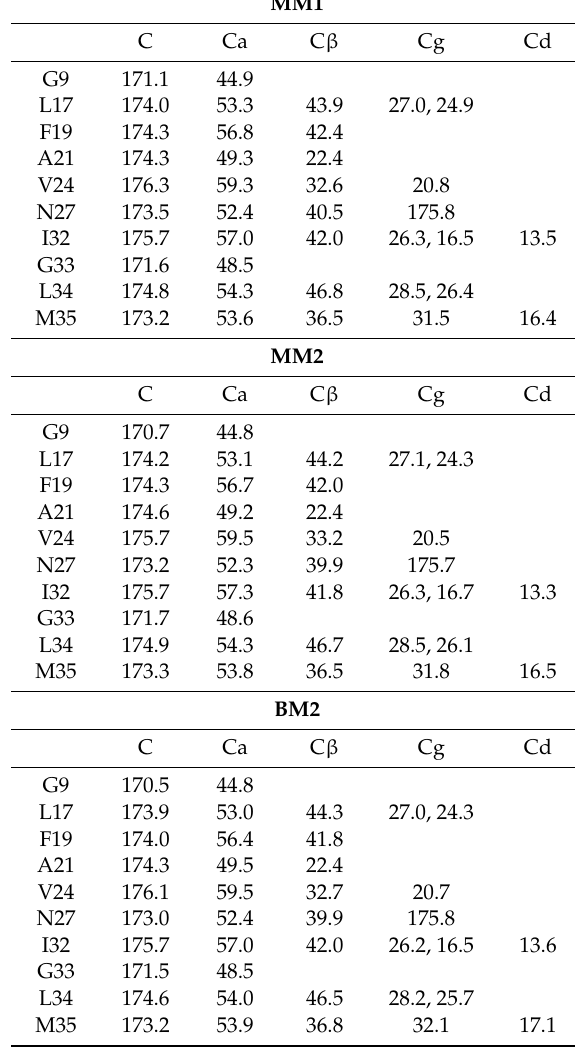
Table 3. Residue-specific 13 C chemical shifts for membrane-associated A β 40 fibrils. MM1 C Ca C